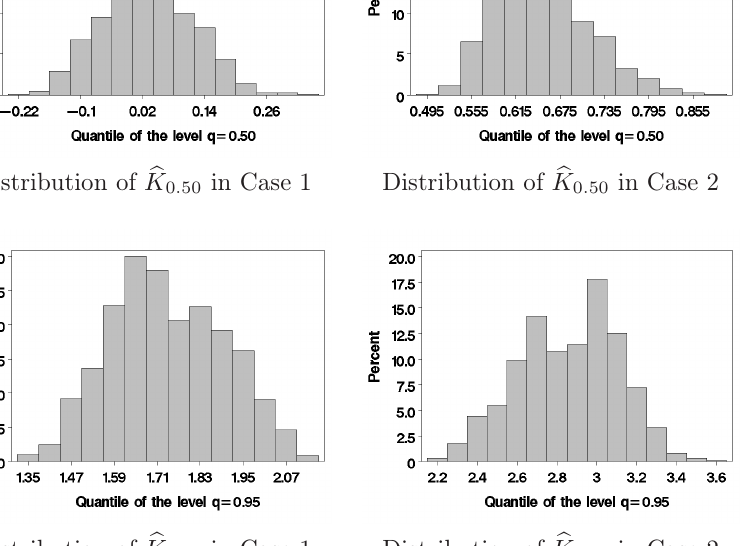
Figure 4. Distribution of the quantile estimator for the levels 0 . 5 , 0 . 95 . Histograms of 1000 quantile estimates in each